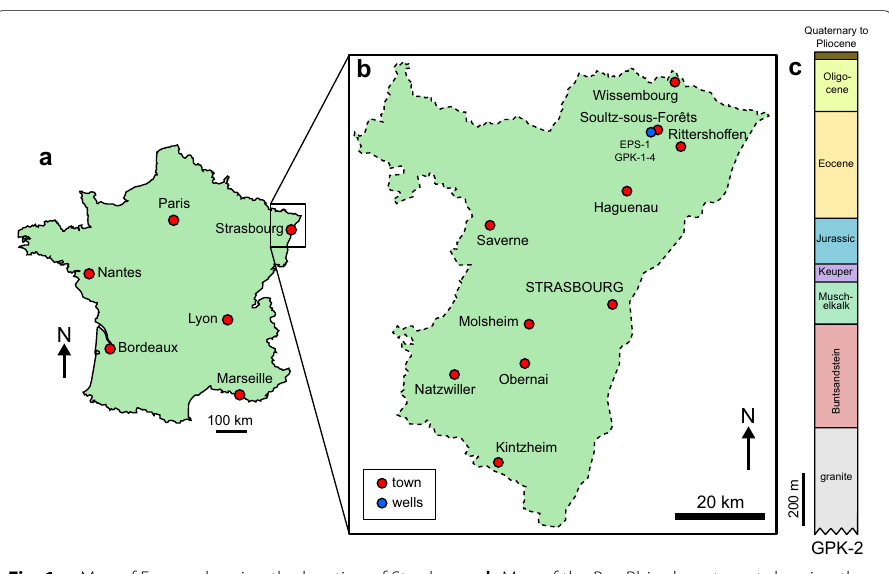
Fig. 1 a Map of France showing the location of Strasbourg. b Map of the Bas-Rhin department showing the location of several towns and cities, including Soultz-sous-Forêts and Rittershoffen, and EPS-1 exploration well and the GPK-1-4 wells at Soultz-sous-Forêts (blue circle). c Stratigraphic column showing the stratigraphy at the Soultz-sous-Forêts geothermal site (for GPK-2; Aichholzer et al. 2016). The reservoir granite was encountered down to the final drilling depth of 5080 m (not shown